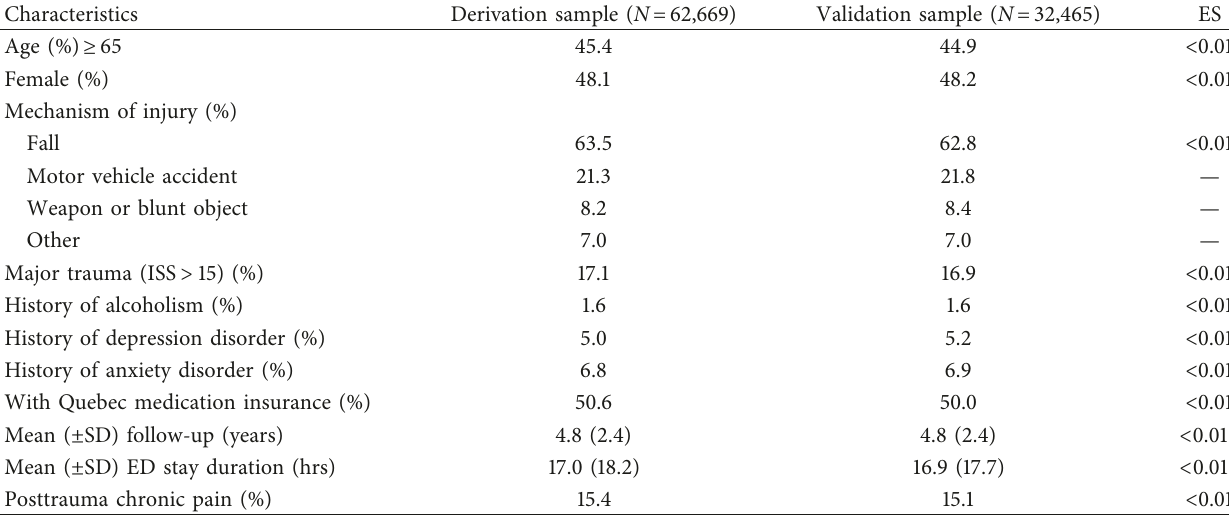
Table 2: Univariate comparisons of patients’ characteristics in the derivation and validation